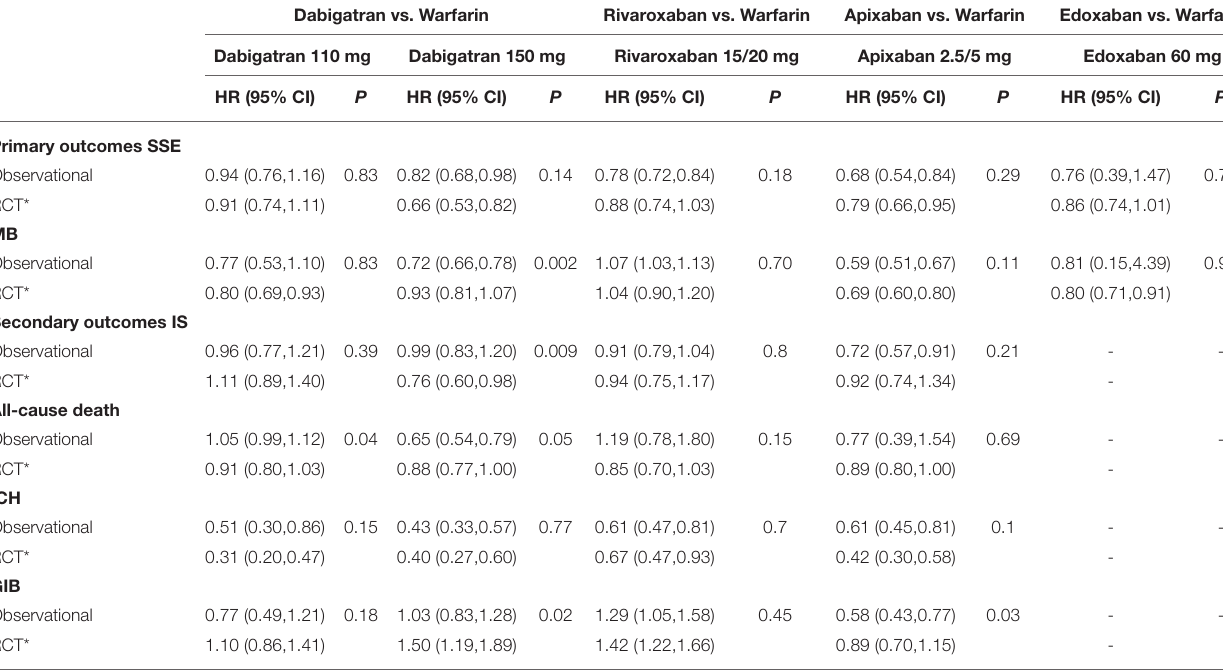
TABLE 3 | Comparing total effect estimates of NOACs vs. warfarin between observational studies and